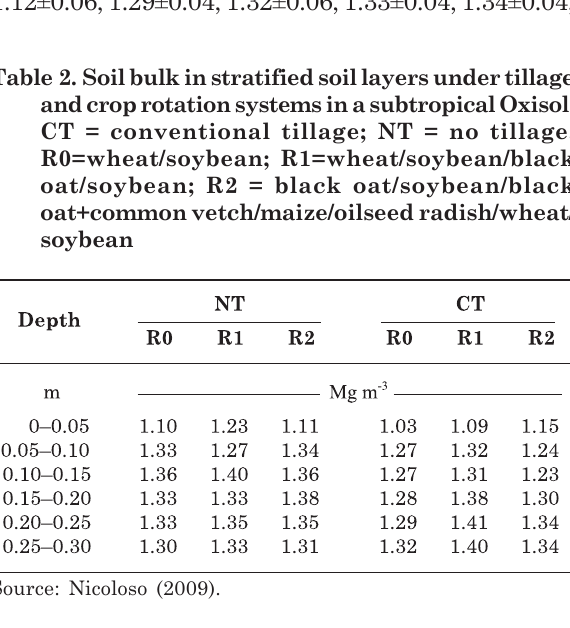
Table 2. Soil bulk in stratified soil layers under tillage and crop rotation systems in a subtropical